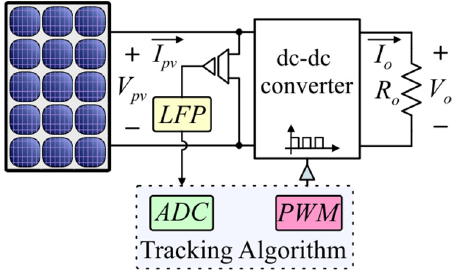
Figure 5. MPPT system for evaluating the proposed tracking algorithm.